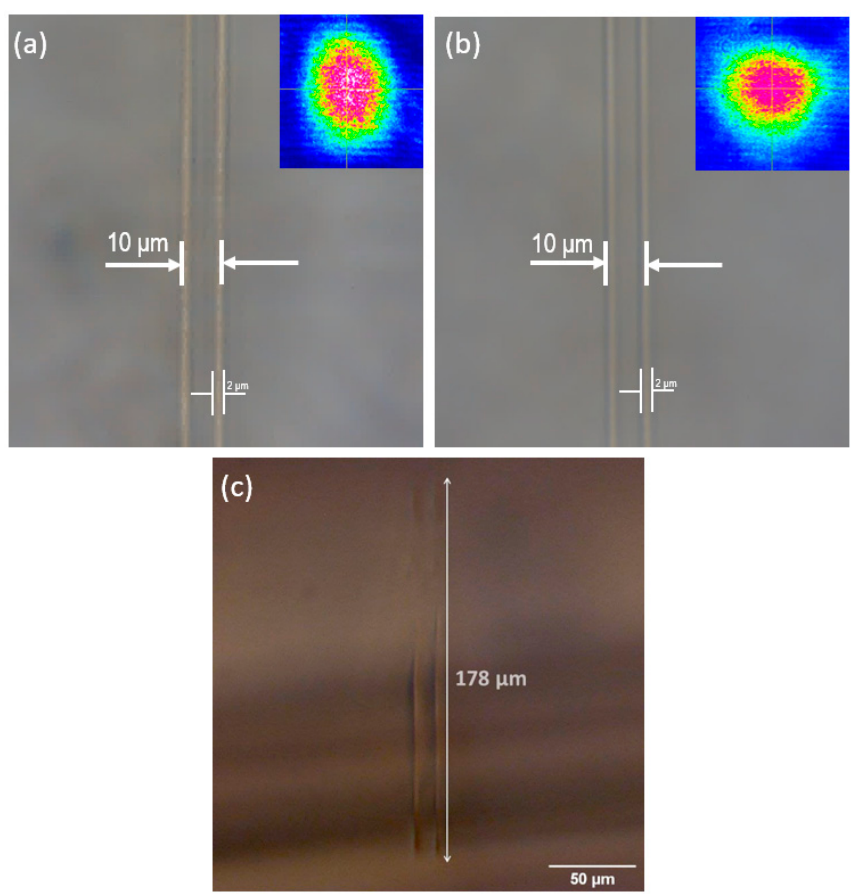
Figure 5. Top view microscope image of the double line waveguide in Nd 3+ -doped GeO 2 -PbO glass with Ag NPs with ( a ) 4 and ( b ) 8 superimposed lines; the near field beam profile (at 632 nm) is presented in the inset for both cases. ( c ) View from the front facet of the 4 superimposed lines showing an apparent depth of focus of 178 µm. Table 2. Results of M x 2 , M y 2 , ∆ n x , ∆ n y , propagation losses and G INT (pulse energy of 30 µ J and processing speed of 0.5